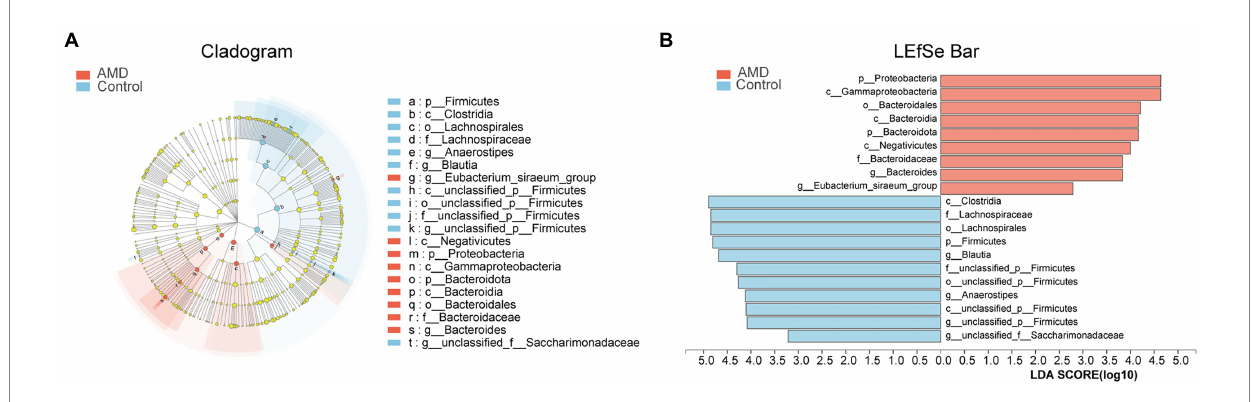
FIGURE 3 Fecal microbiota profile in the both groups at different taxonomic levels. (A) Cladogram of the linear discriminant analysis (LDA) effect size (LEfSe) analysis from the phylum level to the genus level of the microbiota in the AMD patients and controls. (B) Bar graph of LDA scores to screen: altered bacteria from phylum level to genus level (LDA score > 2.5).